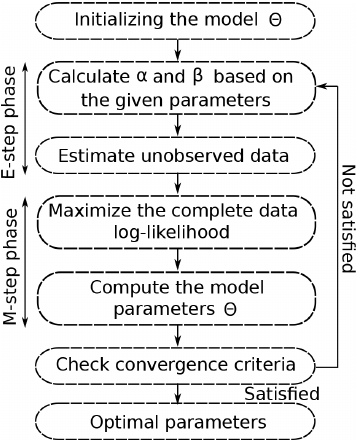
Figure B1. Expectation–maximization algorithm for a HMM pa- rameter